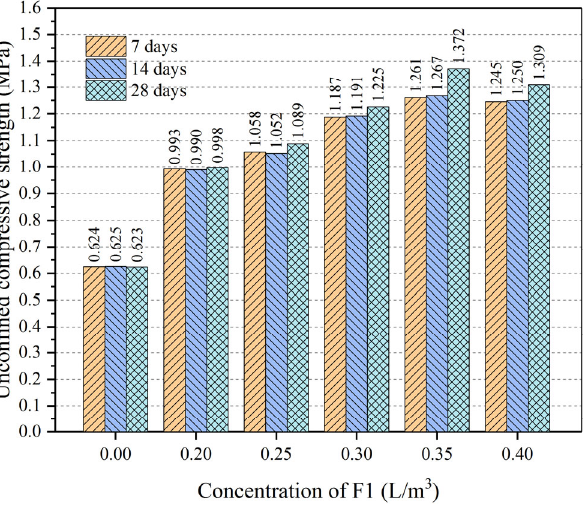
Figure 7. UCS of glacial till with different concentrations of F1 and different curing ages.